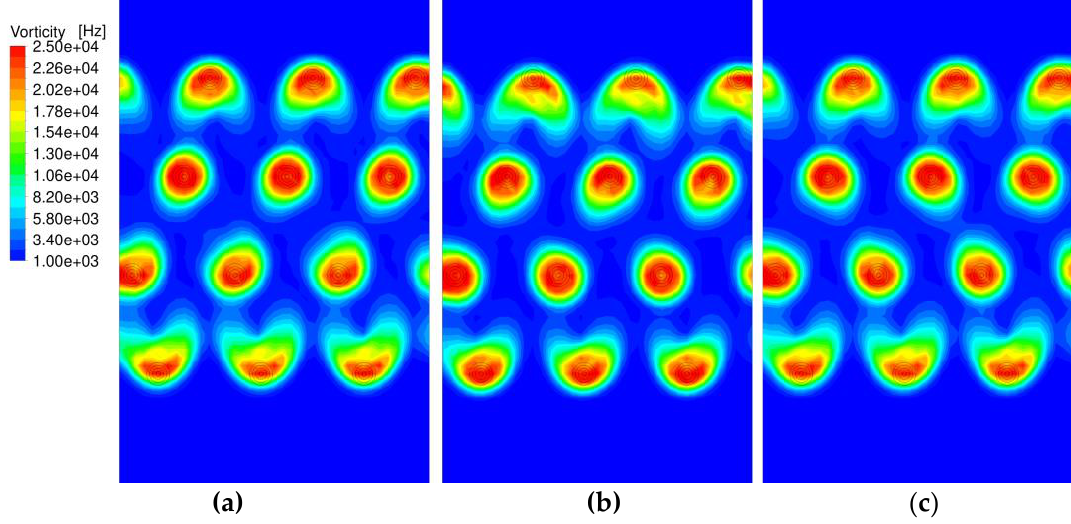
Figure 11. Simulation of the vorticity for different directions of rotation 3 cm underneath the spinning beam: ( a ) same direction for all nozzles; ( b ) alternating directions, ( c ) center rows rotate opposite to outer rows.